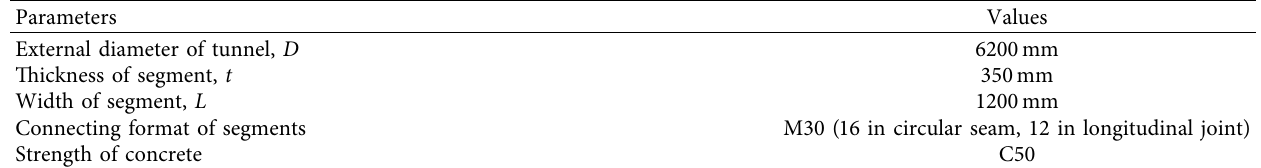
Table 2: The design parameters of